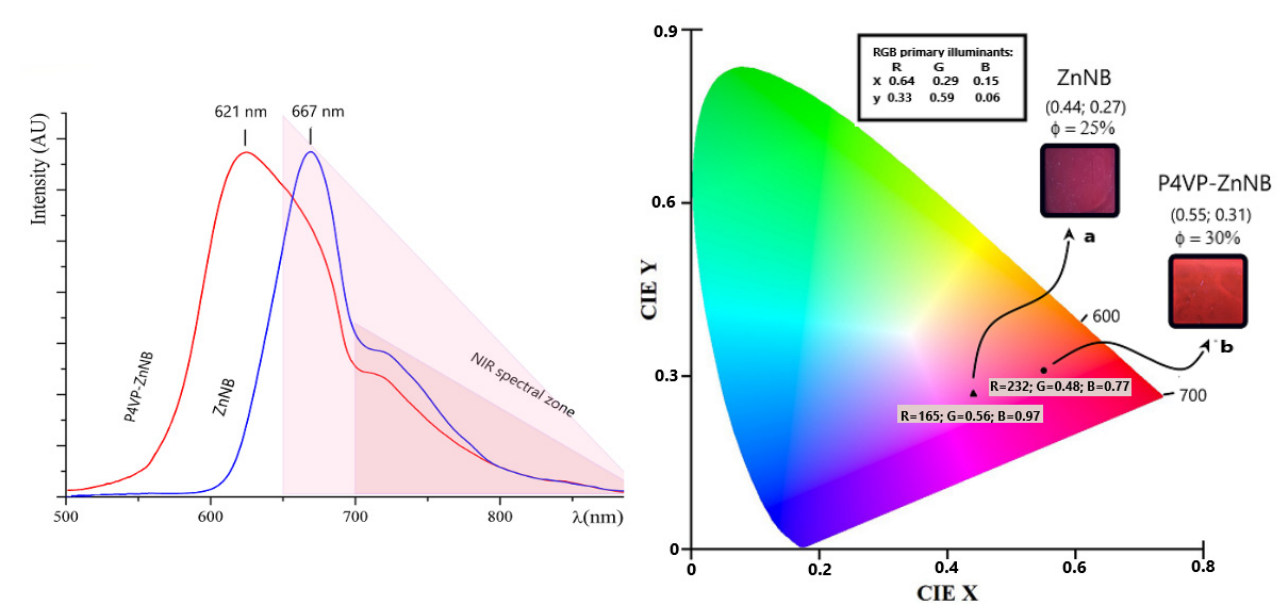
Figure 2. Emission pattern of ZnNB complex and 20% w / w P4VP-ZnNB polymer, and their representation as diagrams. Panel on the left: emission curves recorded on the solid compounds and spin-coated onto quartz slides. The dark pink triangle represents the NIR region; the light pink triangle represents the emission spectral region typically employed in the bioimaging technique. Panel on the right: CIE 1931 color space diagram (in emission) for the same samples (photographed in the inset under a typical UV lamp at 365 nm) and PLQYs. (a) ZnNB film slide. (b) P4VP-ZnNB film slide.